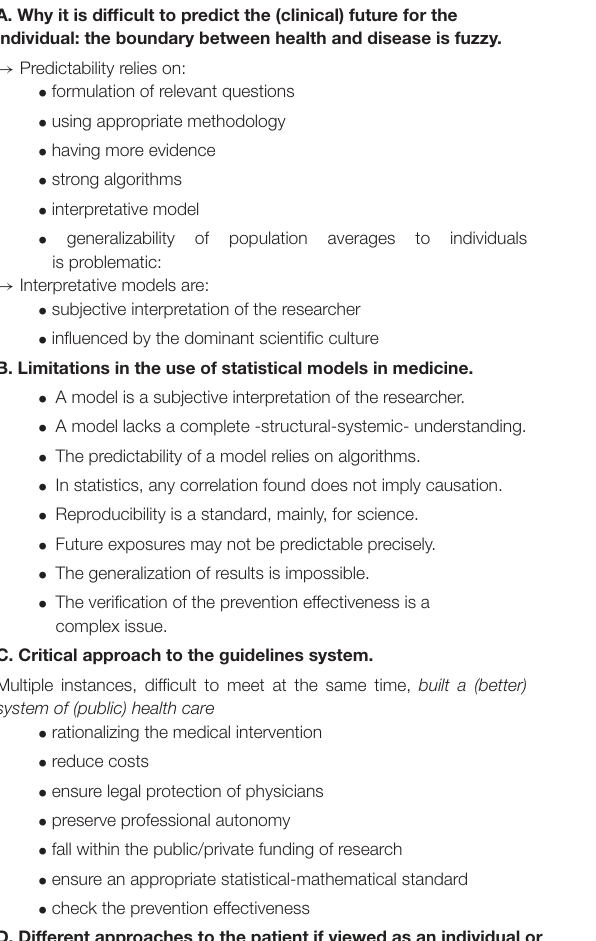
TABLE 2 | Predicting health and